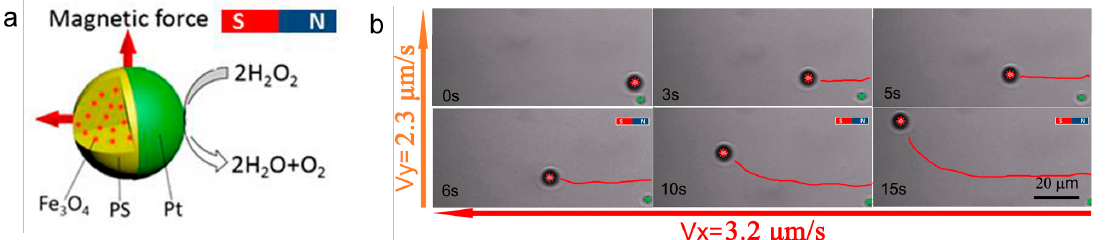
Figure 5. ( a ) Scheme and ( b ) video snapshots of a manipulated magnetic micro-motor with 3 wt % H 2 O 2 , no surfactant. The green particle stands as a reference particle. H 2 O 2 , no surfactant. The green particle stands as a reference